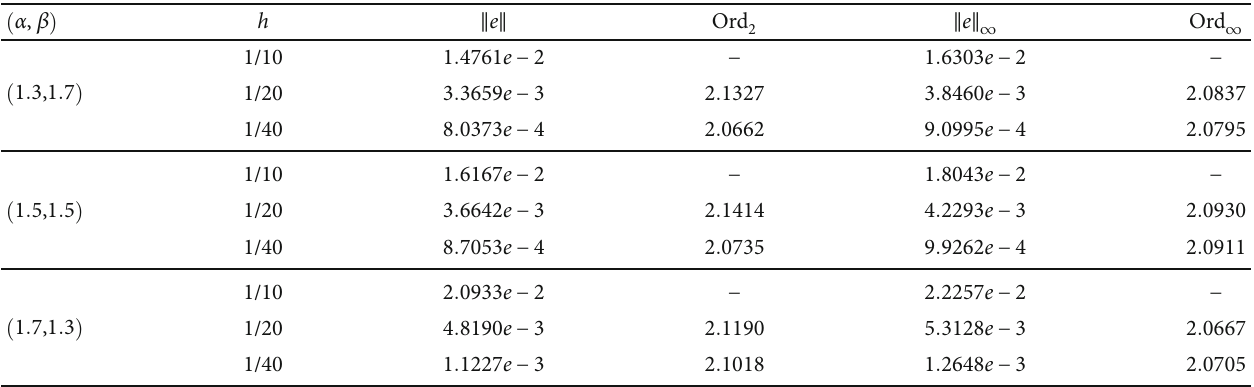
Table 5: l 2 -and l ∞ -errors and their convergence orders of (28) – (30) for 1 < α < 2 in the spatial direction for (75) with τ = 1/1000 for Example 3.